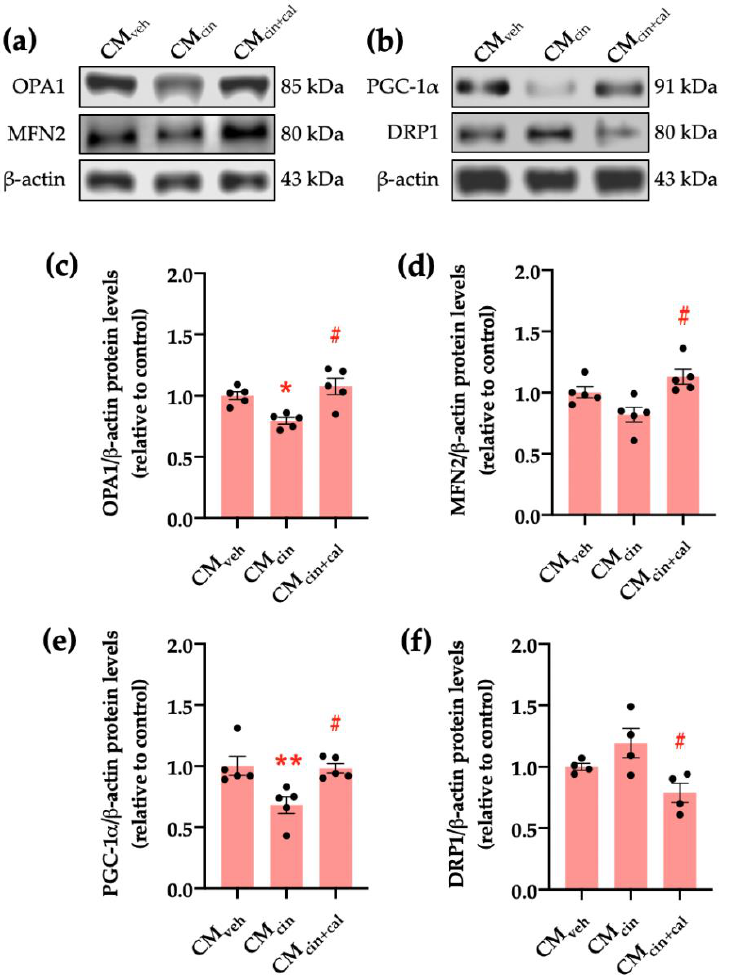
Figure 6. CaSR activation in SW872 pre-adipocytes induces the secretion of factors that alter proteins governing mitochondrial dynamics in HepG2 cells: ( a ) immunodetection of OPA1 and MFN2 protein levels in HepG2 cells exposed to CM veh , CM cin , and CM cin+cal ; ( b ) immunodetection of PGC-1 α and DRP1 protein levels in treated HepG2 cells; quantification of ( c ) OPA1; ( d ) MFN2; ( e ) PGC-1 α ; and ( f ) DRP1 protein levels. Each dot represents an individual experiment ( n = 4 – 5). * p < 0.05 and ** p < 0.01 versus the control, # p < 0.05 versus CM cin , Friedman ’ s test, and Dunn ’ s post-hoc test. Next, we analyzed the mitochondrial transmembrane potential ( ∆ ψ ) through im- munofluorescence using the ∆ ψ -sensitive probe MitoTracker Orange (MTO) normalized by mtHsp70 as a marker of mitochondrial mass. We observed that HepG2 cells exposed to CM cin had a decreased MTO/mtHsp70 fluorescence ratio ( p < 0.05), indicative of de- creased ∆ ψ (Figure 7a,b). In addition, CM cin -treated cells presented a higher number of average mitochondrial area ( p < 0.08) (Figure 7c,d). Altogether, these results indicate that CM cin treatment in pre-adipocytes induces the secretion of factors that promote mitochon- drial fragmentation and the decrease of bioenergetics in HepG2 cells, thus suggesting mitochondrial